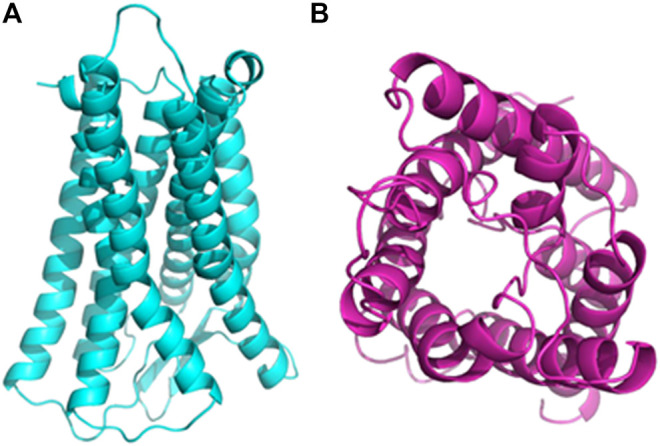
3D structural models. (A) The 3D structural model of opioid receptor. (B) The 3D structural model of AQP4.